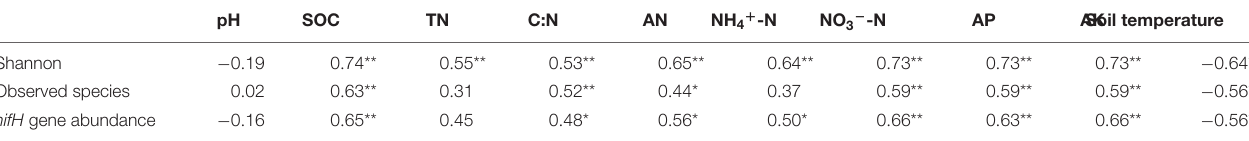
TABLE 1 | The correlations of soil properties with α -diversity and nifH gene abundance in the wheat rhizosphere.